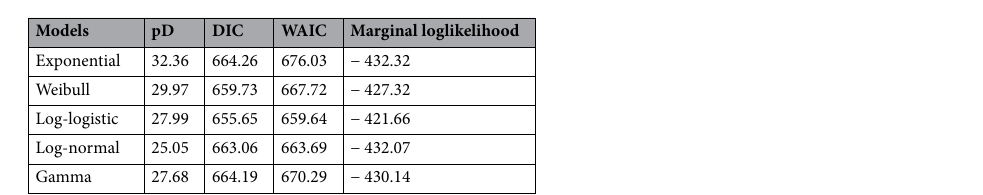
Table 2. Parametric survival models with their corresponding DIC, WAIC and Marginal log-likelihood.